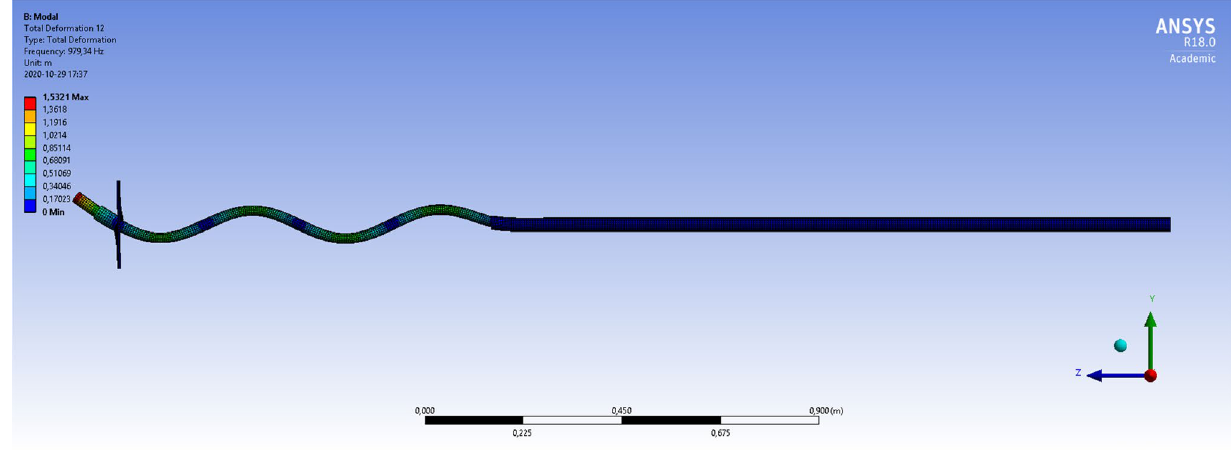
Fig. 10 The example of diagnosed rock bolts with lack of grout approximately equal to 0.80 m from the roof strata surface (rock strata elements not shown) with one of the modes of 979.3